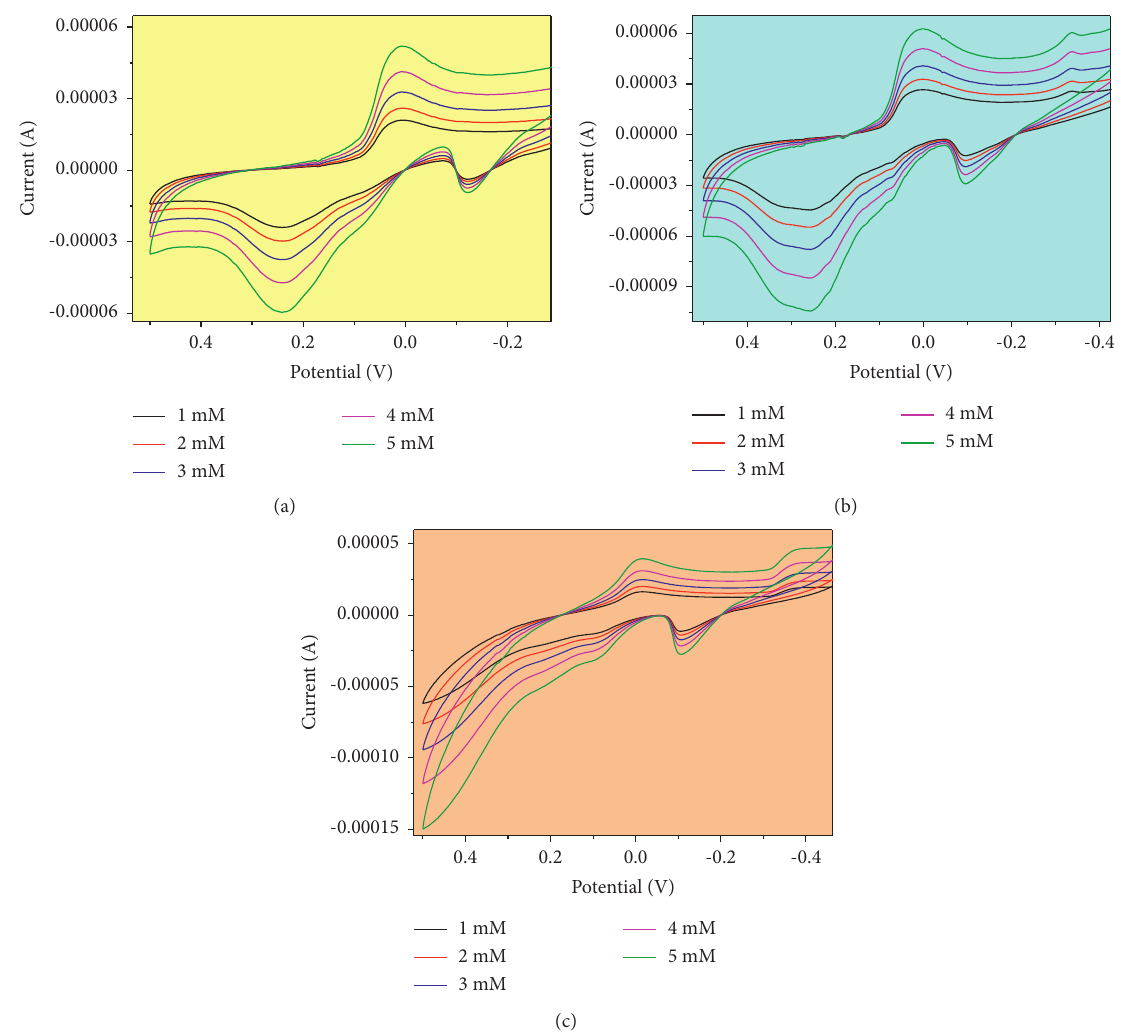
Figure 11: CV plots of Co 3 O 4 ((a) 1:2, (b) 1 :1, and (c) 2:1 volume ratios) modified CPWE ascorbic acid